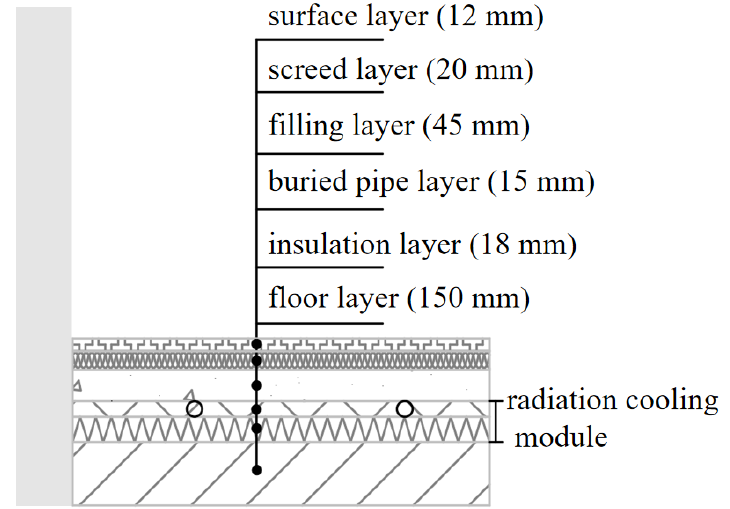
Figure 1. Photographs of the floor plan and experimental building. ( a ) Experimental site, ( b ) pipe